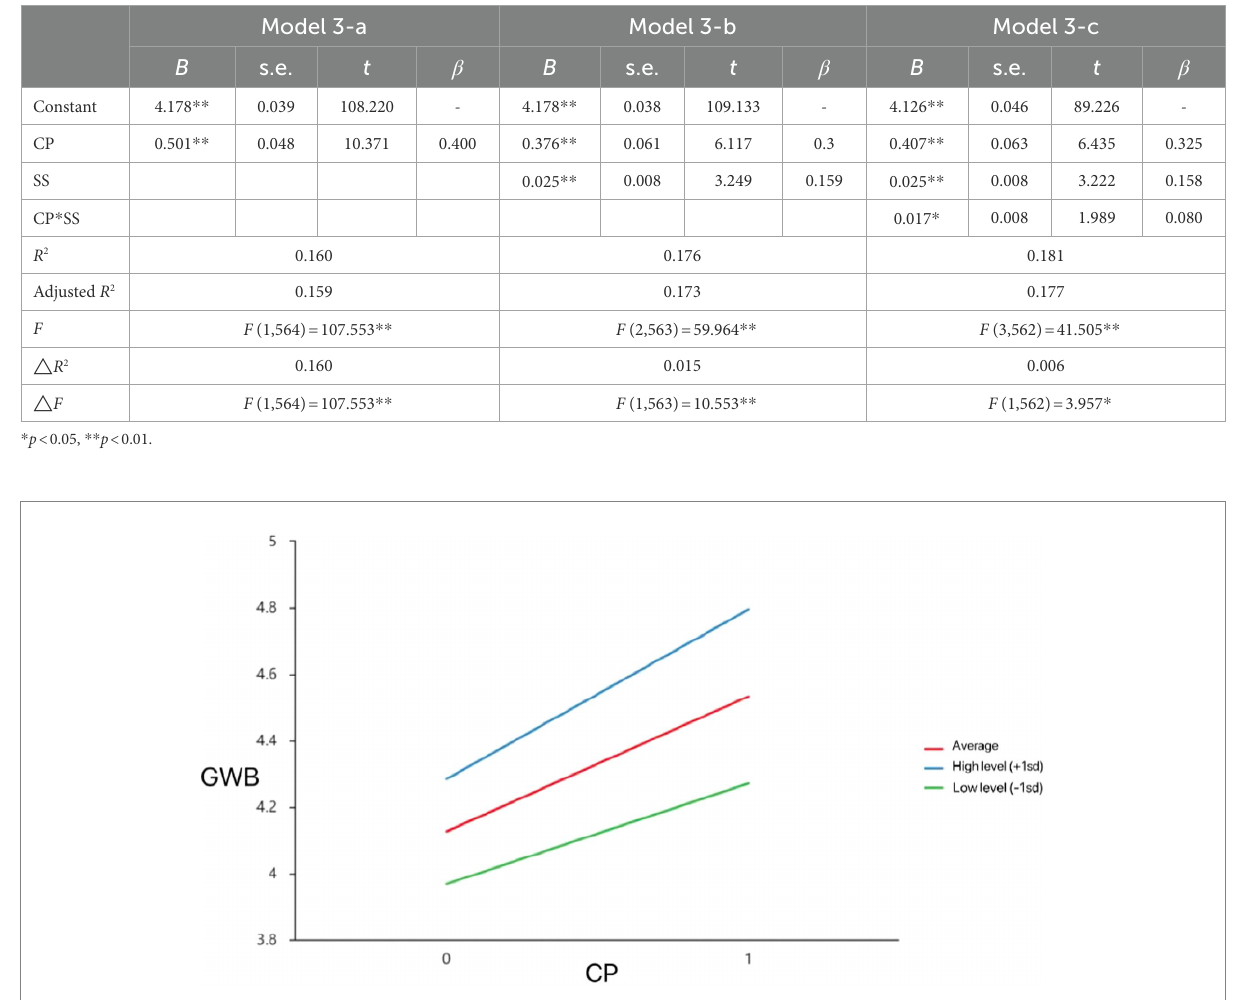
TABLE 6 Community participation and general well-being: moderating roles of social